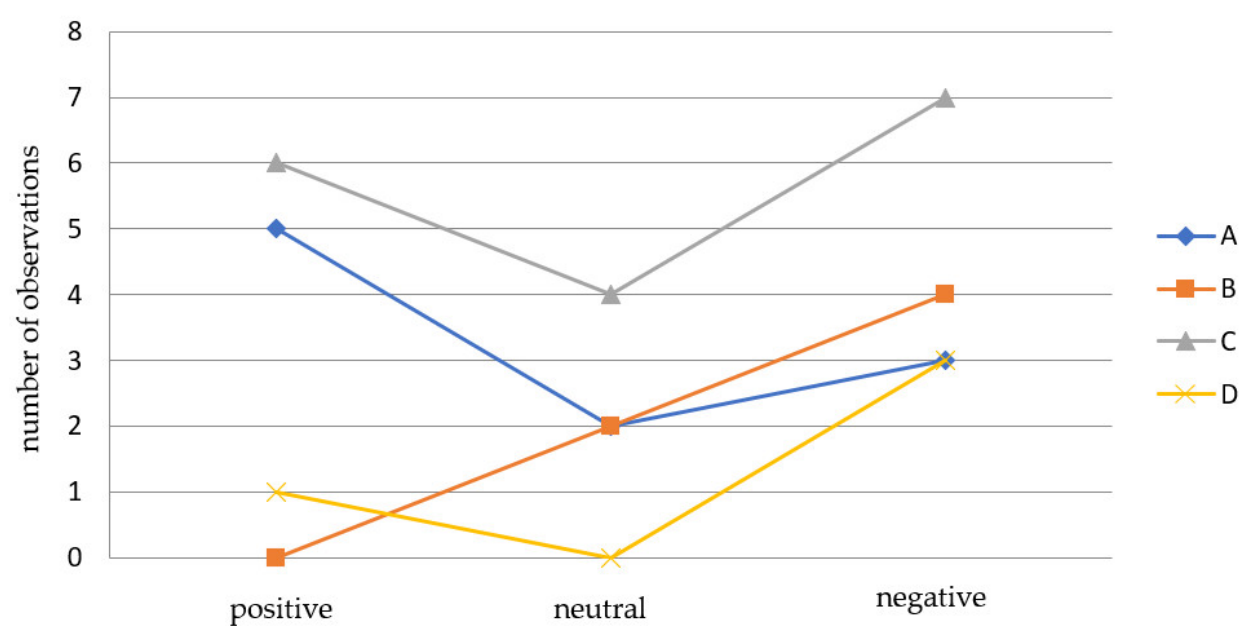
Figure 1. Attitudes toward woody biomass as a renewable energy source on social media (A: Information and science websites; B: Study reports; C: Social media 1: Twitter; D: Social media 2: Facebook).